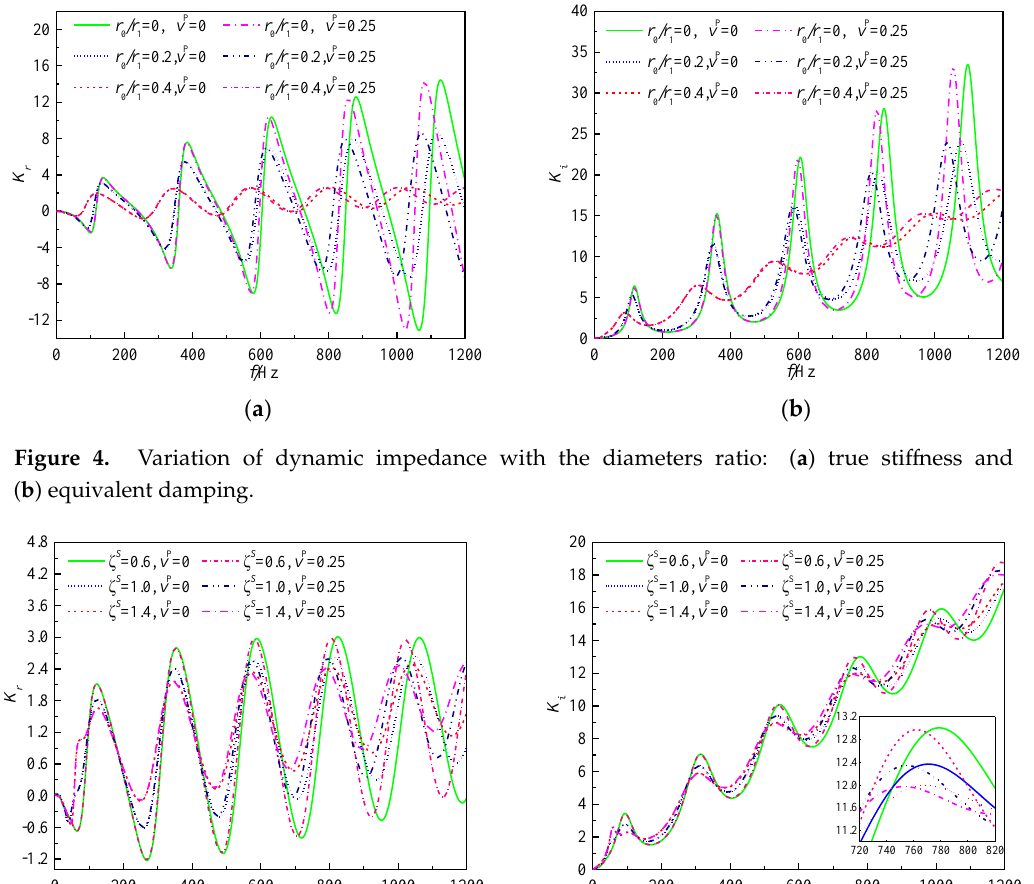
Figure 3. Variation of dynamic impedance with pile Poisson’s ratio: ( a ) true sti ff ness and ( b ) equivalent damping.